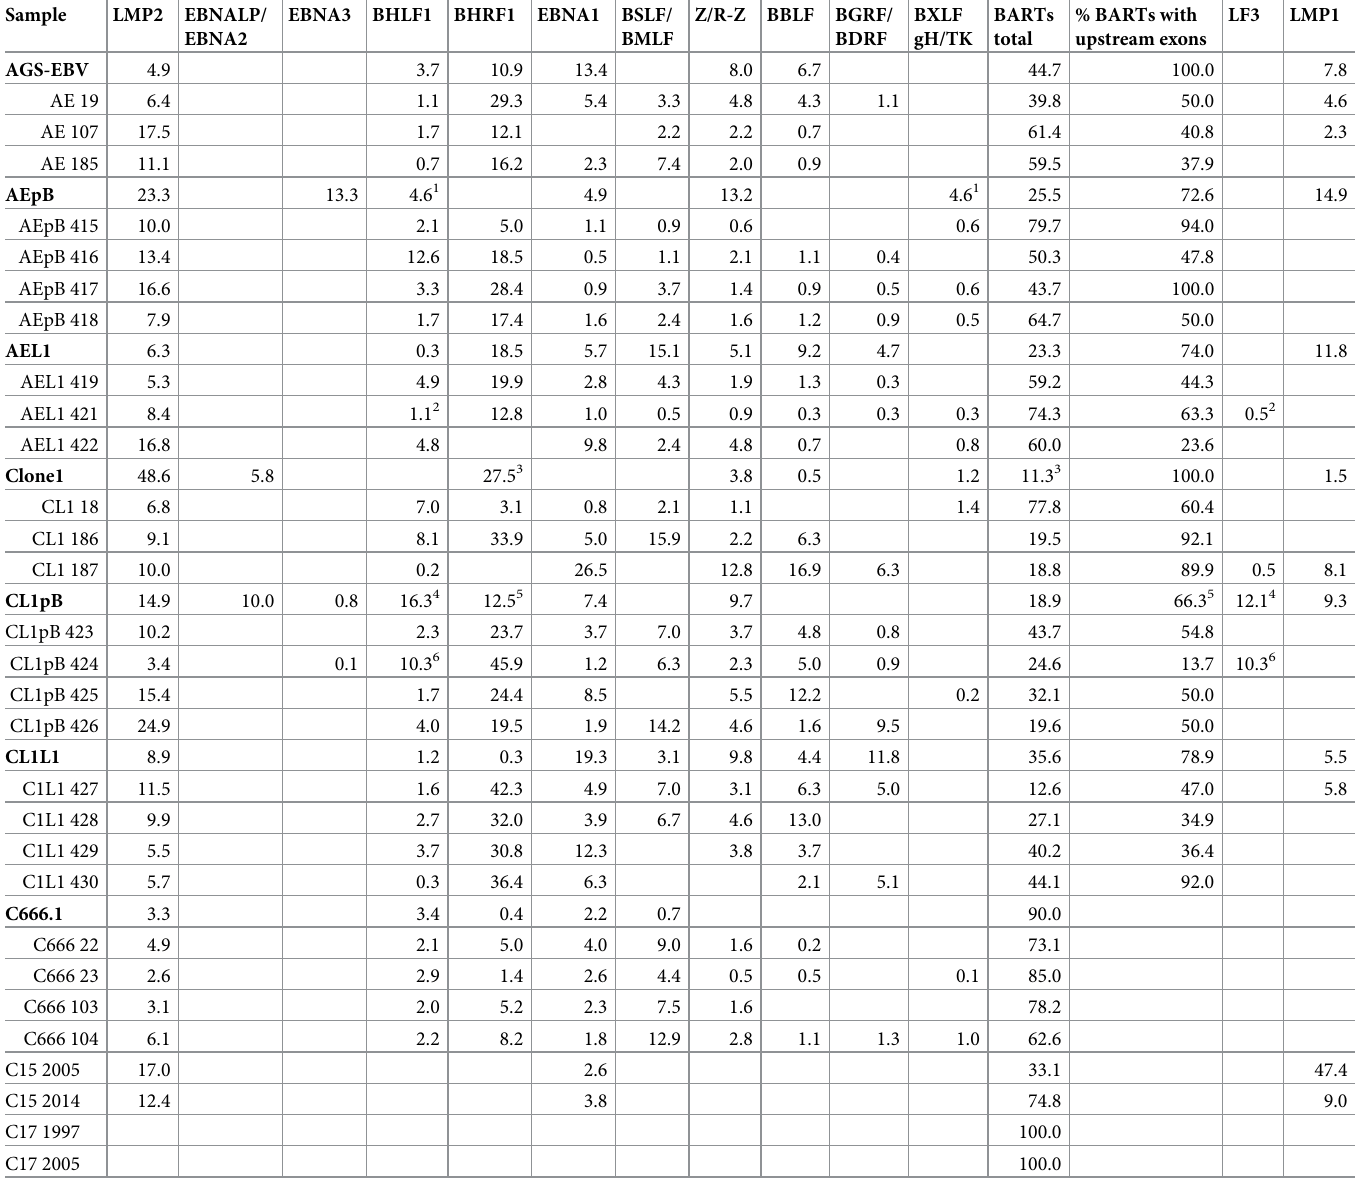
Table 7. Average percent of EBV spliced transcripts from Cufflinks and Stringtie � .